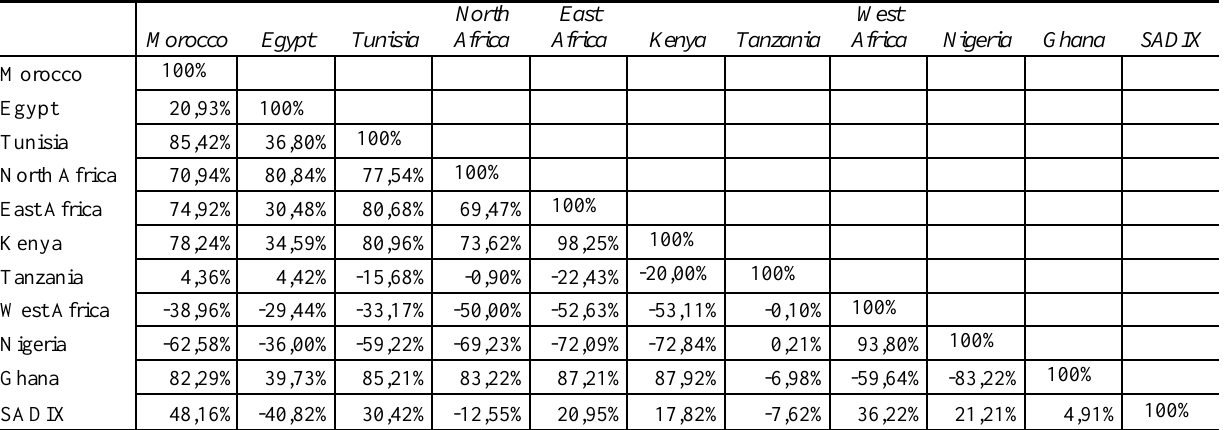
Table 8: Four Regional indices and individual market indices